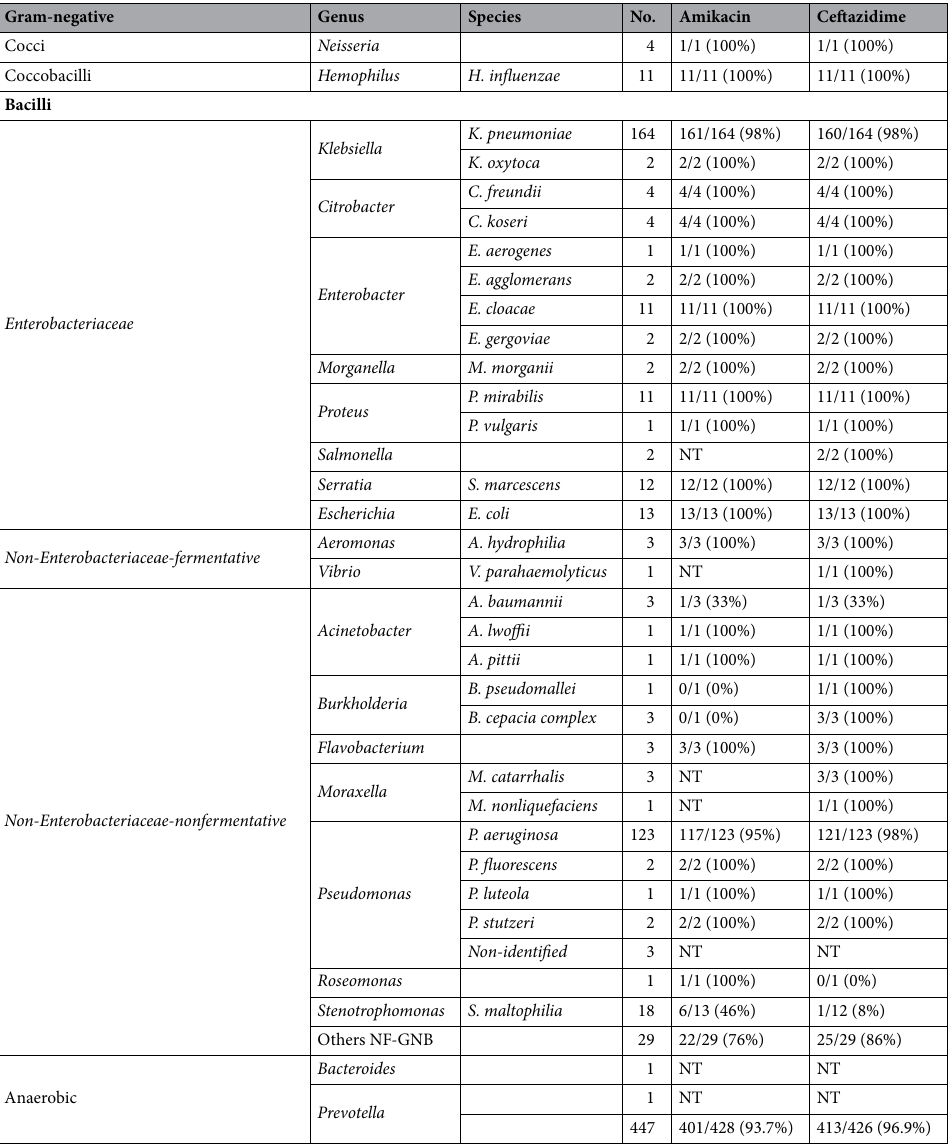
Table 3. Susceptibility of Gram-negative bacterial isolates to ceftazidime and amikacin. NFGNB nonfermenting Gram-negative bacilli, NT not